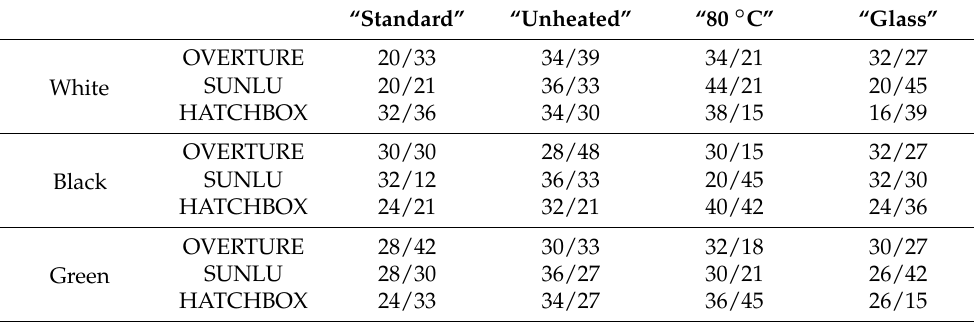
Table 2. Filament scoring across all four printer conditions, with varying bed temperature and bed surface, based upon dimensional accuracy and mechanical properties ( S Dimension and S Property separated as S Dimension / S Property